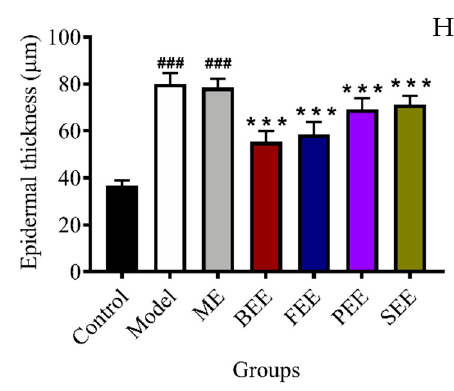
Figure 3. E ff ects of ethanolic extract of Paeonia su ff ruticosa flowers on UVB-induced epidermal thickening in the mice. Representative images of histological observation by H&E staining of mouse dorsal skin (400 × ). ( A ) control group: no irradiation; ( B ) model group: irradiated group with no treatment; ( C ) model + emulsifier (ME) group: irradiated group treated with emulsifier; ( D ) bud ethanolic extract (BEE) group: irradiated group treated with 2.0% ( w / w ) BEE in emulsifier; ( E ) flower ethanolic extract (FEE) group: irradiated group treated with 2.0% ( w / w ) FEE in emulsifier; ( F ) petal ethanolic extract (PEE) group: irradiated group treated with 2.0% ( w / w ) PEE in emulsifier; ( G ) stamen ethanolic extract (SEE) group: irradiated group treated with 2.0% ( w / w ) SEE in emulsifier. ( H ) Epidermal thickness. Data were expressed as mean ± SD ( n = 6). *** p < 0.001 versus ME group; ### p < 0.001 versus control